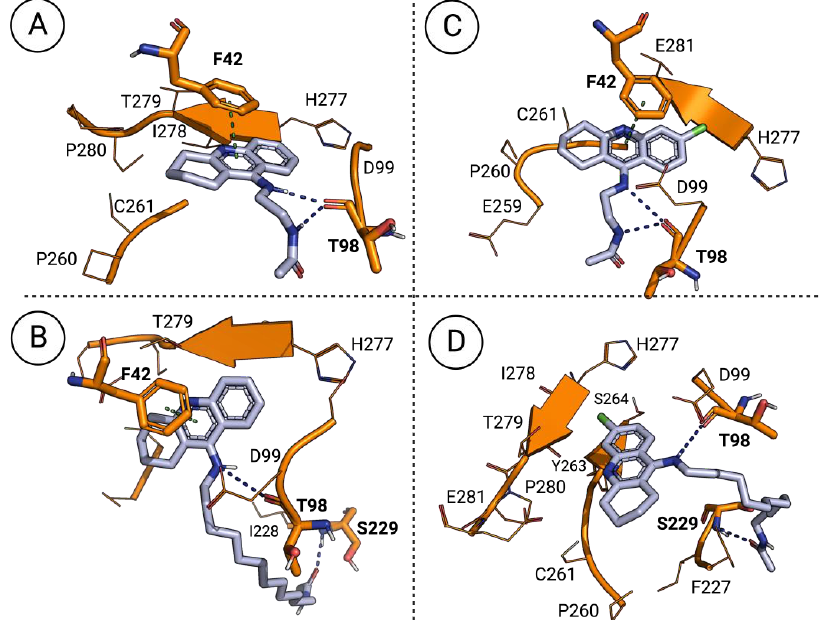
Figure 3. Docking poses of the N -acetylated 9-alkylamino-1,2,3,4-tetrahydroacridines in the AdoMet DC’s catalytic site: ( A ) docking pose of 7.a ; ( B ) docking pose of 7.h ; ( C ) docking pose of 7.g ; ( D ) docking pose of 7.n . Blue dashed lines correspond to hydrogen bonds and green dashed lines correspond to π–π interactions .